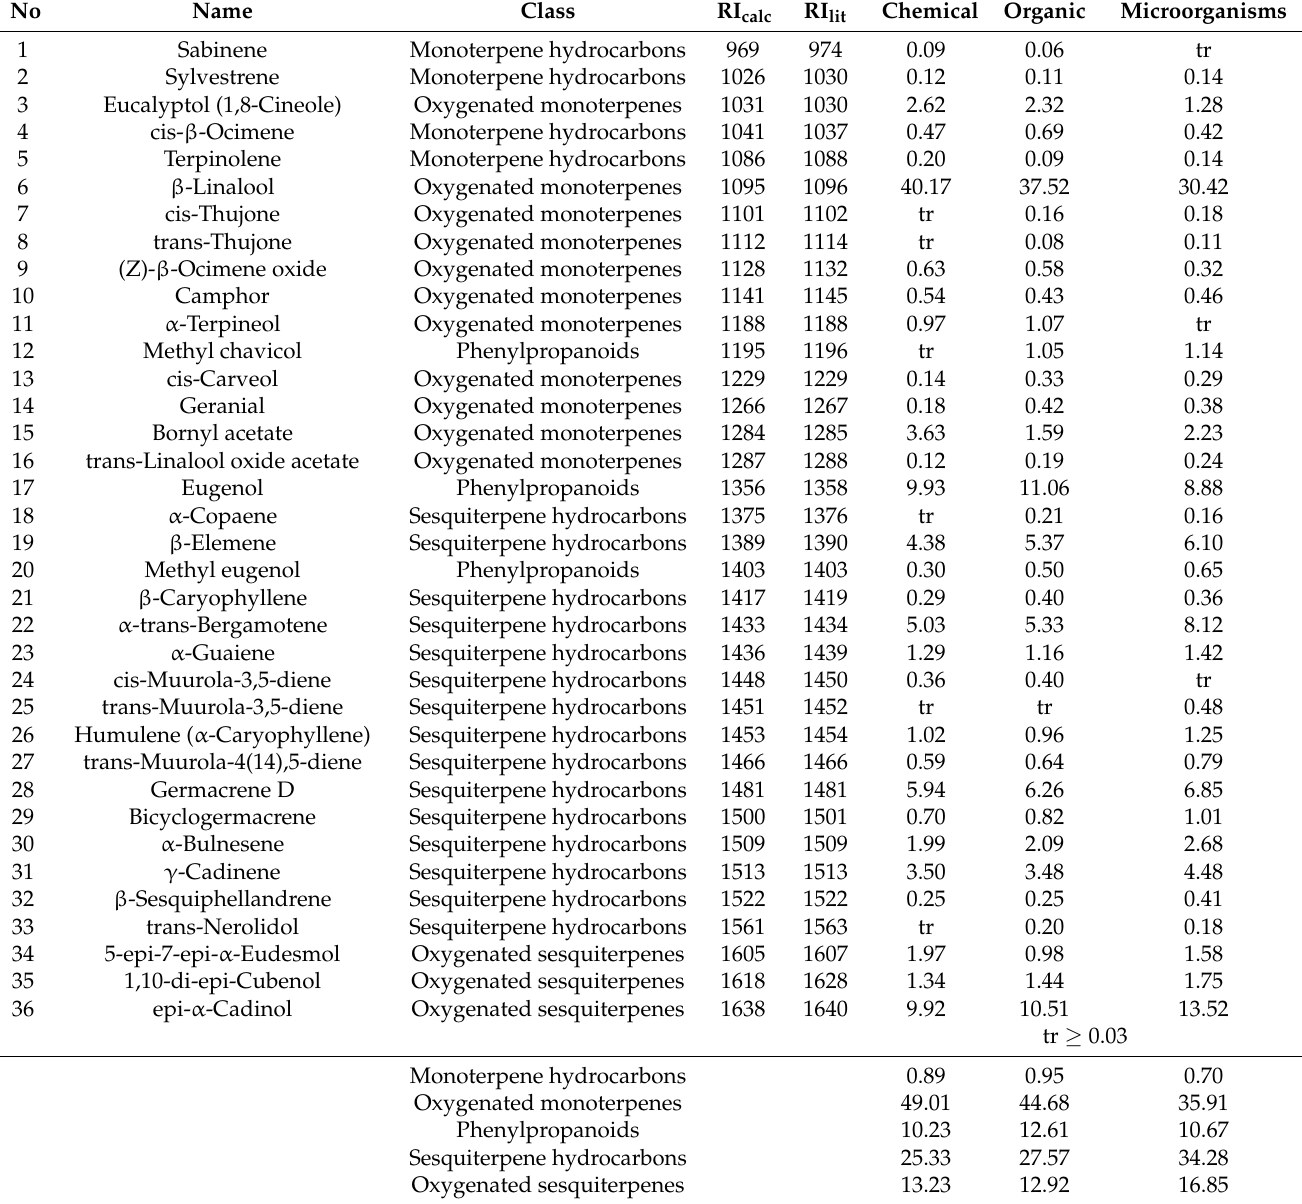
Table 11. Influence of fertilization on essential oil composition of ‘Cuisoare’